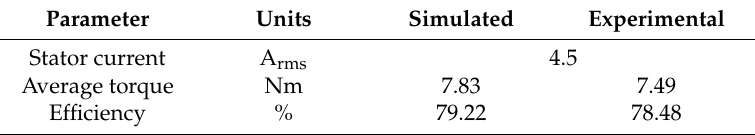
Table 4. Performance comparison.